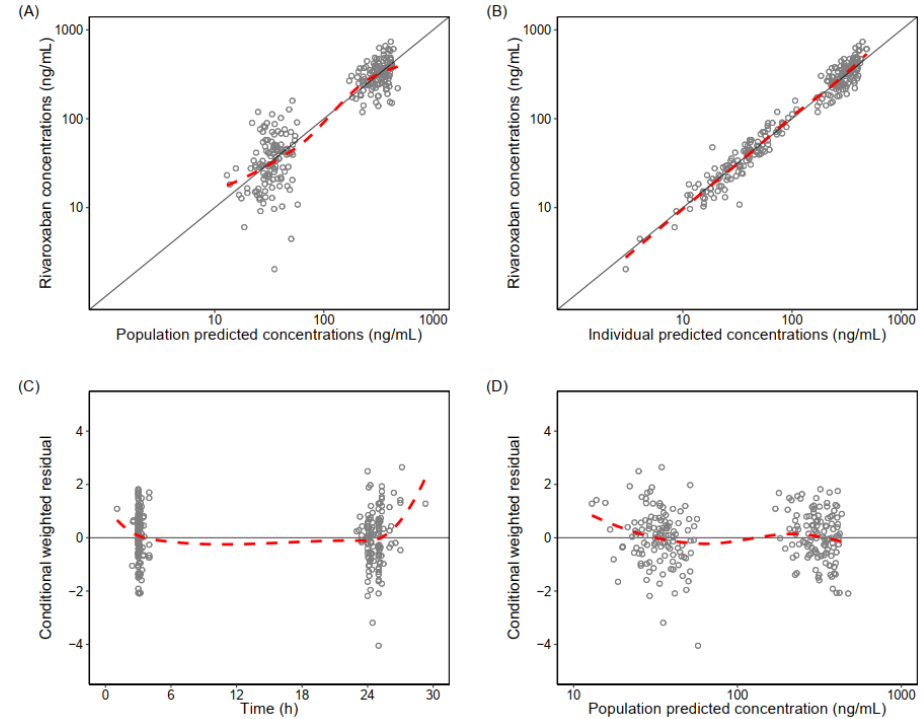
Figure 1. Goodness-of-fits of the final population pharmacokinetic model of rivaroxaban. ( A ) Observed rivaroxaban concentrations vs. population predictions, ( B ) observed rivaroxaban concen- trations vs. individually predicted concentrations, ( C ) conditionally weighted residual vs. time, and ( D ) conditionally weighted residual vs. population predictions. The open circles represent the observed rivaroxaban concentrations. The solid black lines are the line of identity or zero-line. The dashed red lines are loess smooth lines (trend lines).